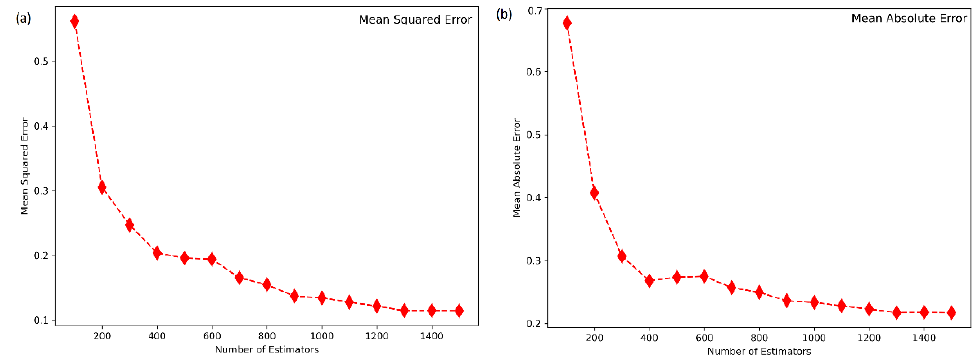
Figure 5. Effect of the number of estimators on gradient boosting regression measured using ( a ) MSE and ( b ) MAE for Zn (g/L) modelling.